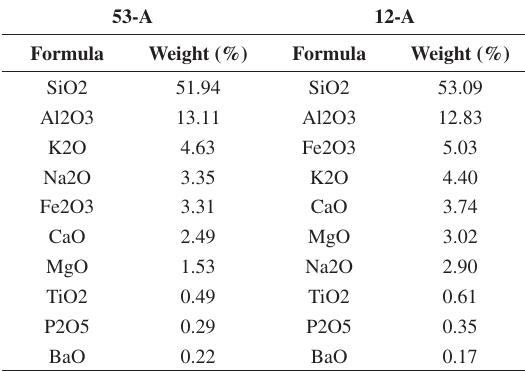
Table 3. Chemical analysis data from X-ray fluorescence spectroscopy.